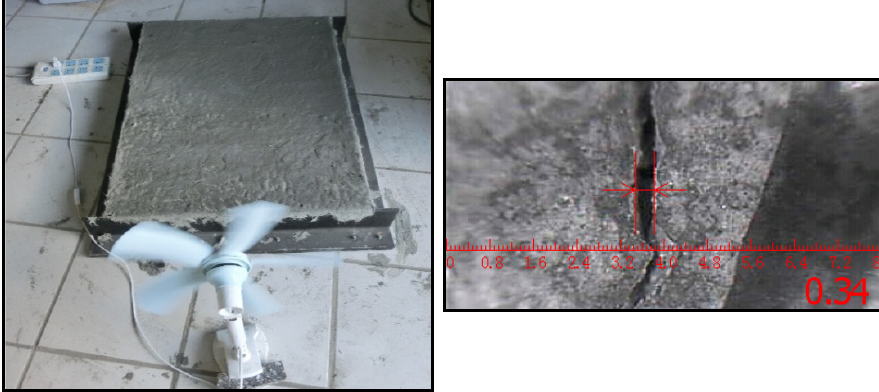
Figure 2. Flatknife-edge restraint experiment and crack test.